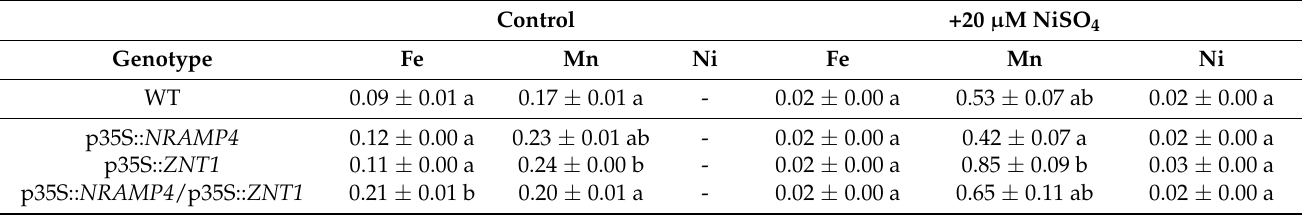
Table 1. Translocation factors (TFs) for Fe, Mn, and Ni in wild-type (WT) and transformed plants grown in hydroponic culture in control conditions or upon Ni supplementation (+20 µ M NiSO 4 ). TFs are expressed as mean ± standard deviation; letters, when different, indicate statistical significance as evaluated by one-way ANOVA plus post-hoc Tukey’s test ( p < 0.05). Control